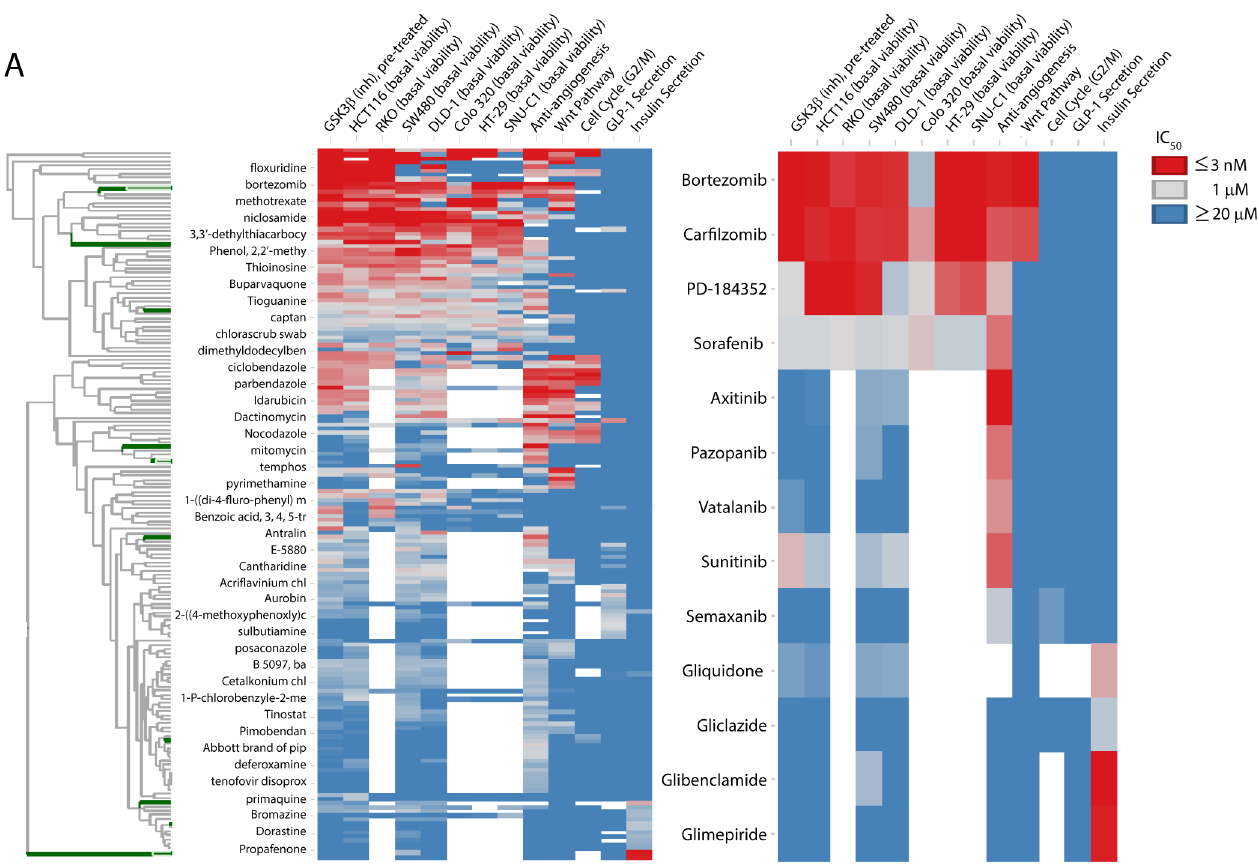
Fig 1. Heatmap representation of activity results for 173 active compounds vs. primary assays from 6 OIDD phenotypic assay modules. The clustering was performed on log10-transformed IC 50 s from S2 Table. The color scale ranges from blue (IC 50 (cid:1) 20 uM) to red (IC 50 (cid:3) 3 nM). The positions of compounds shown in the inset are highlighted in green on the compound